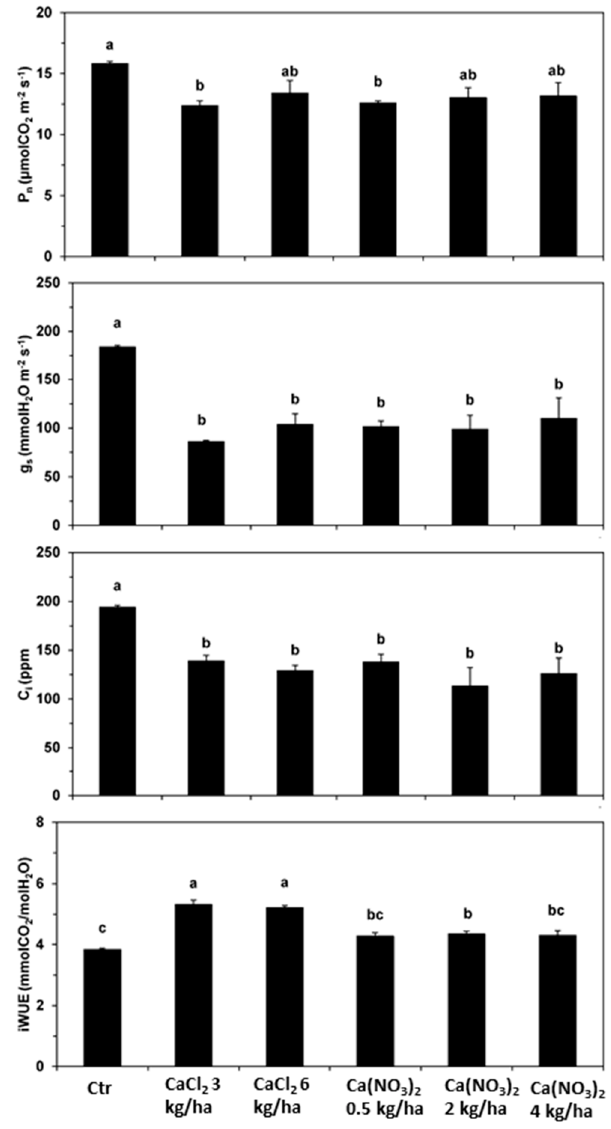
Figure 2. Leaf gas exchange parameters, net photosynthesis rate (P n ), stomatal conductance to water vapor (g s ), internal CO 2 concentration (C i ), as well as variation in the instantaneous water use efficiency (iWUE = P n /E) in leaves of S. tuberosum Agria variety, at 2nd August 2018 (after the 3rd leaf application). The concentrations of P n , g s and iWUE ± S.E. ( n = 6); Letters a, b and c indicate significant differences, of each parameter, between treatments (statistical analysis using the single factor analysis of variance (ANOVA) test, p ≤ 0.05).